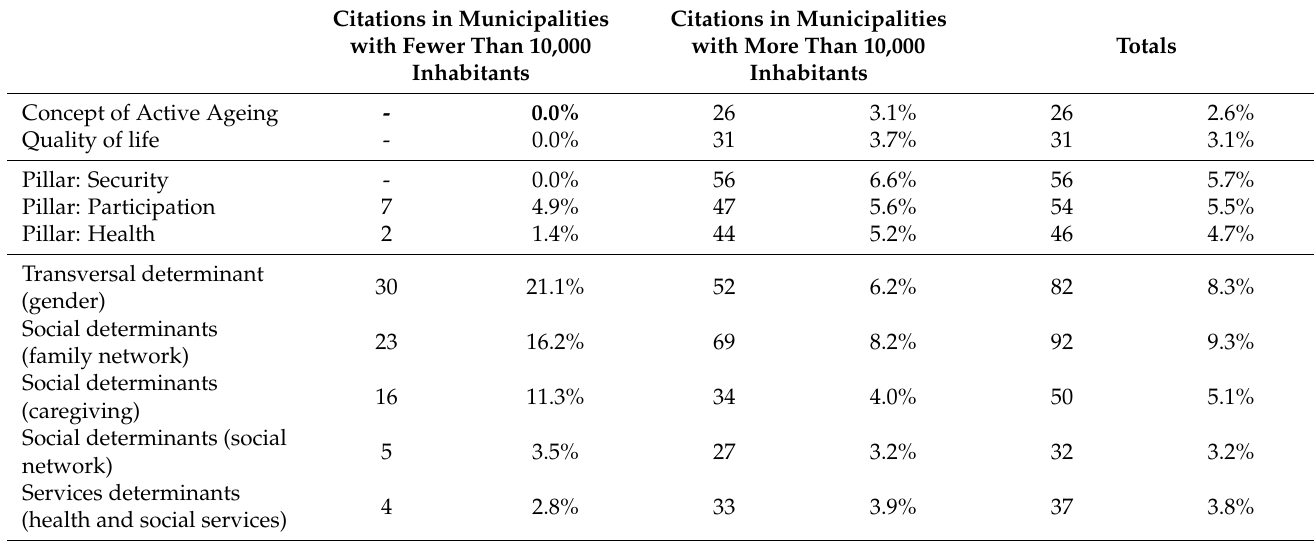
Table 3. Citation distribution for most commonly used codes 1 in codification based on municipality